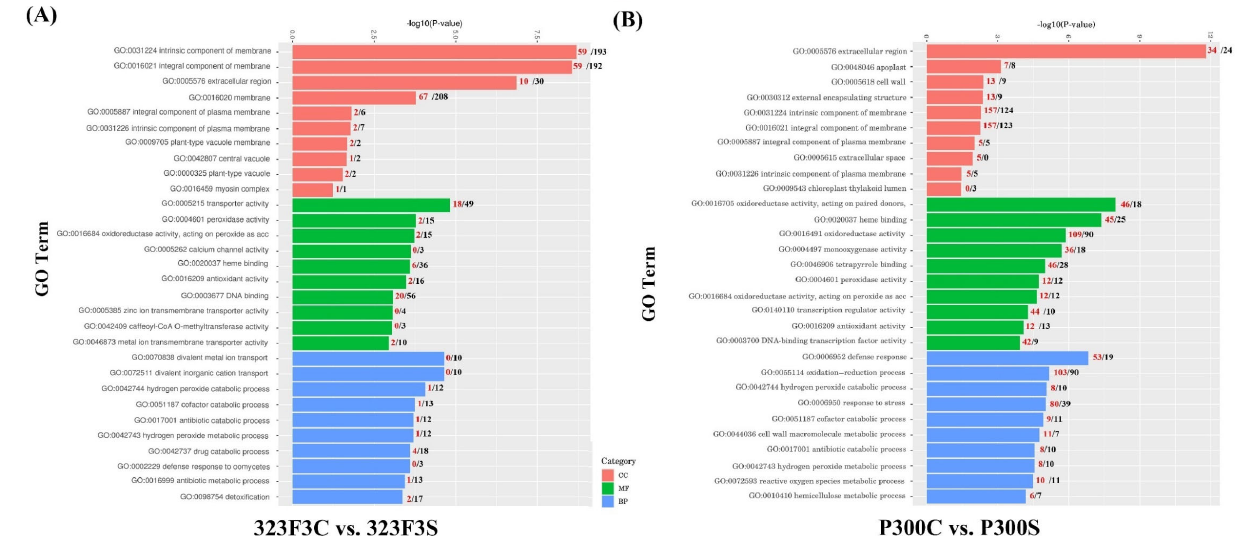
Figure 7. GO enrichment analysis of the DEGs identified in the 323F3C vs. 323F3S ( A ) and P300c vs. P300S ( B ) comparisons. The topmost enriched GO terms under the three main GO categories are shown. The numbers of the up-regulated and down-regulated genes in each category are represented by red and black numbers, respectively. CC, cellular component; MF, molecular function; BP, biological process.